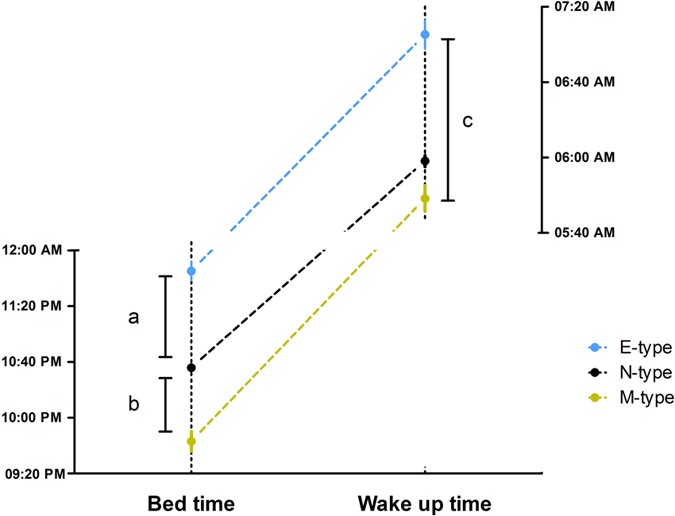
Sleep patterns according to chronotype.Means and standard error of the mean for Bed time and Wake up time extracted from the PSQI. E-types (N = 125) presented later bedtime in comparison to M-types (N = 97) and N-types (N = 830) subjects. M-types subjects also went to bed earlier than N-types. Bonferroni post-hoc comparisons for (a and b) produced p < 0.0001. E-types also presented later wake up time in comparison to M-types and N-types, Bonferroni post-hoc comparison for (c) yielded p < 0.0001.